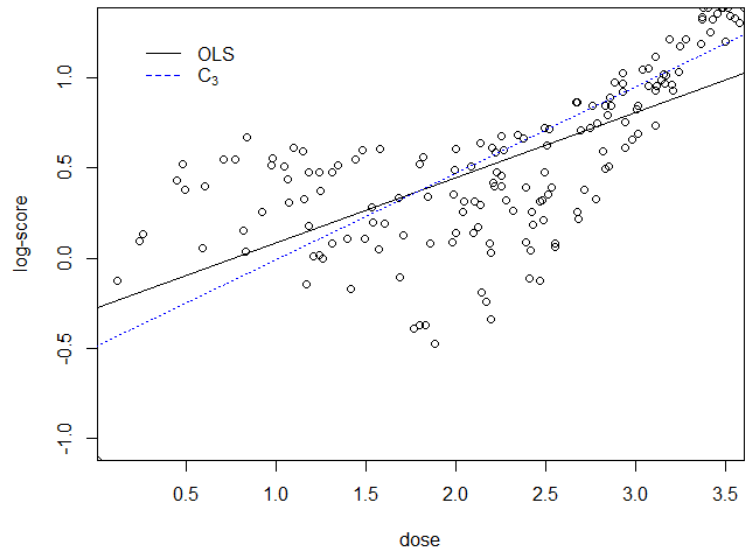
Figure 10. Regression for cell